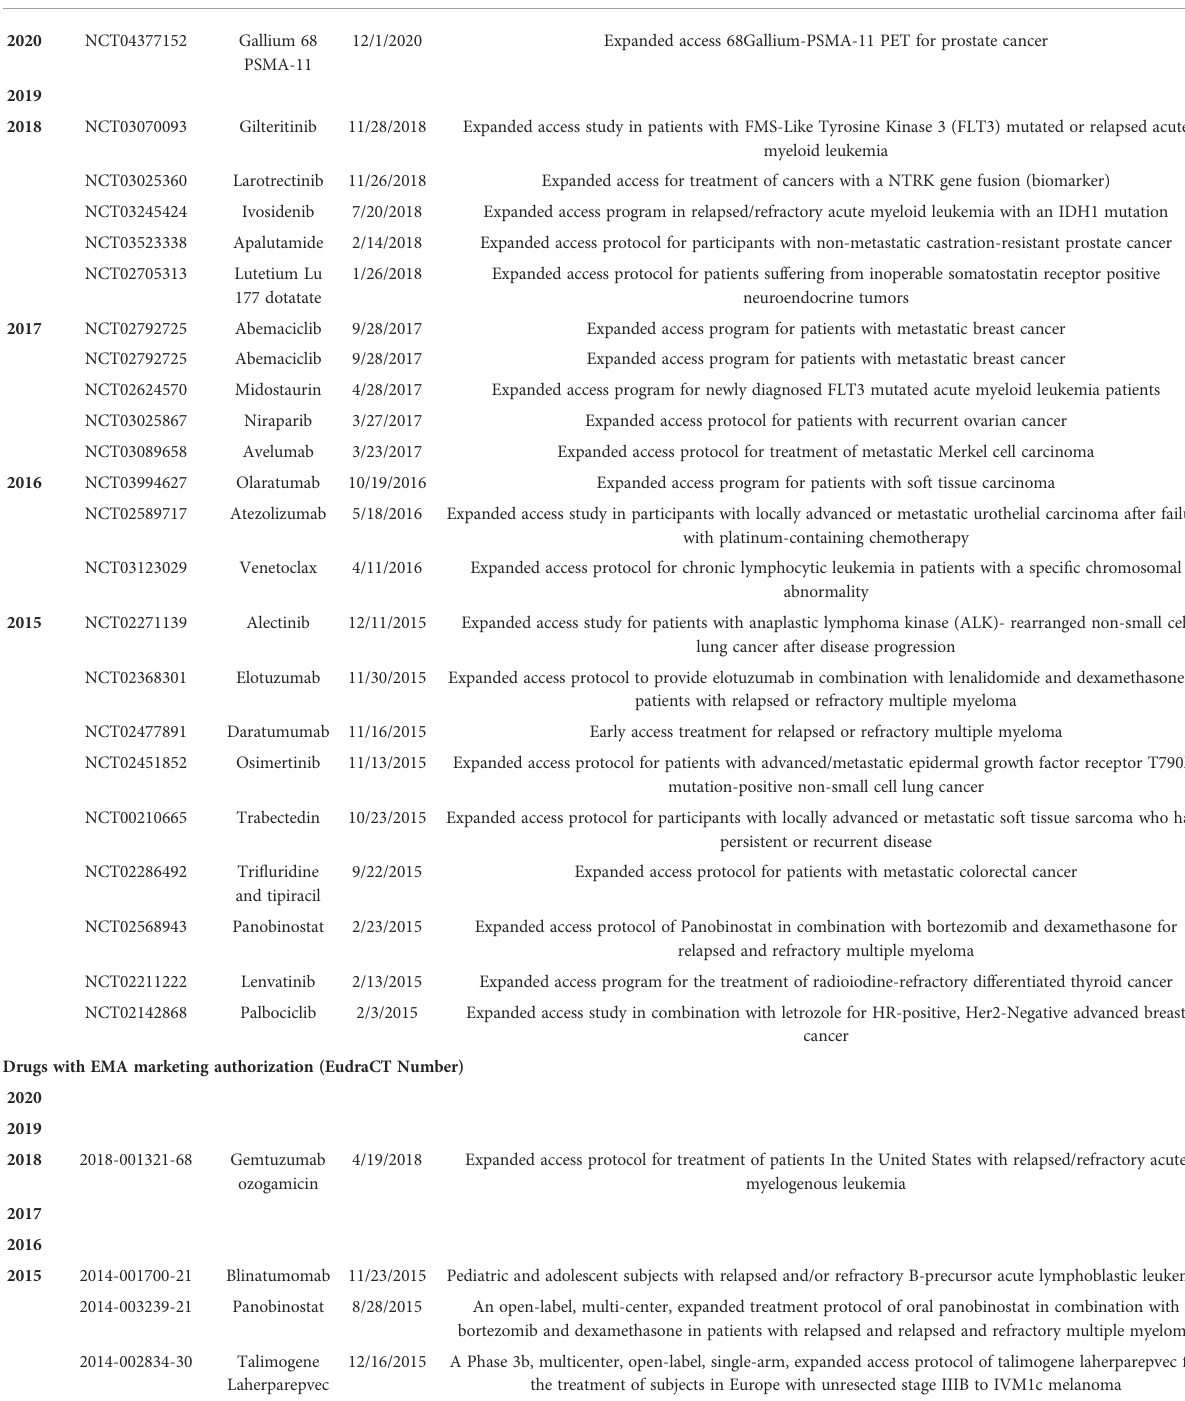
TABLE 1 Oncology investigational new drugs with an expanded access protocol prior to marketing authorization by the FDA or EMA for the period 2015-2020. Year Trial identi fi er InMP/INN Date